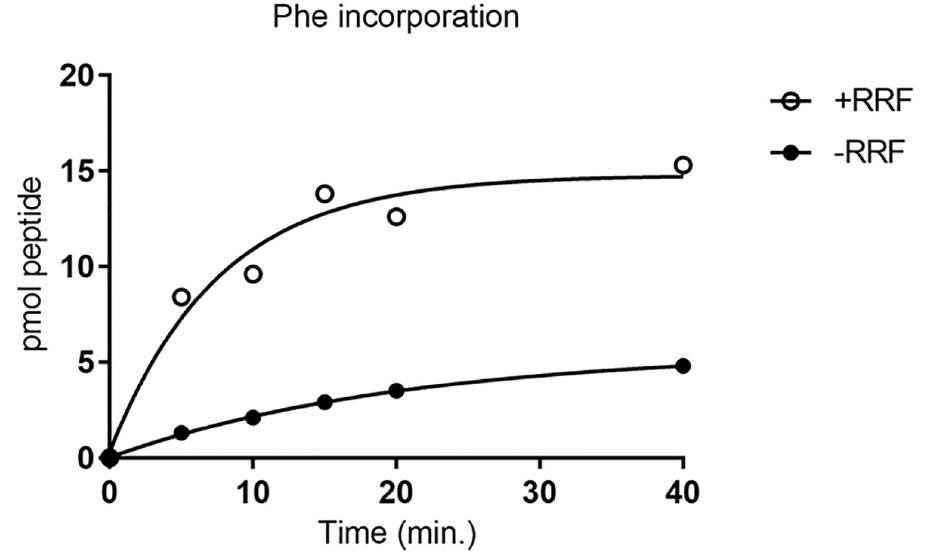
Fig 9. u-ORF translation is stimulated by RRF. u-ORF reading was measured by incorporation of [ 3 H]- Phenylalanine coded for by UUU and UUC codons into hot TCA insoluble materials. Reaction mixtures were as described in Materials and Methods. The concentration of Mg 2+ was 4